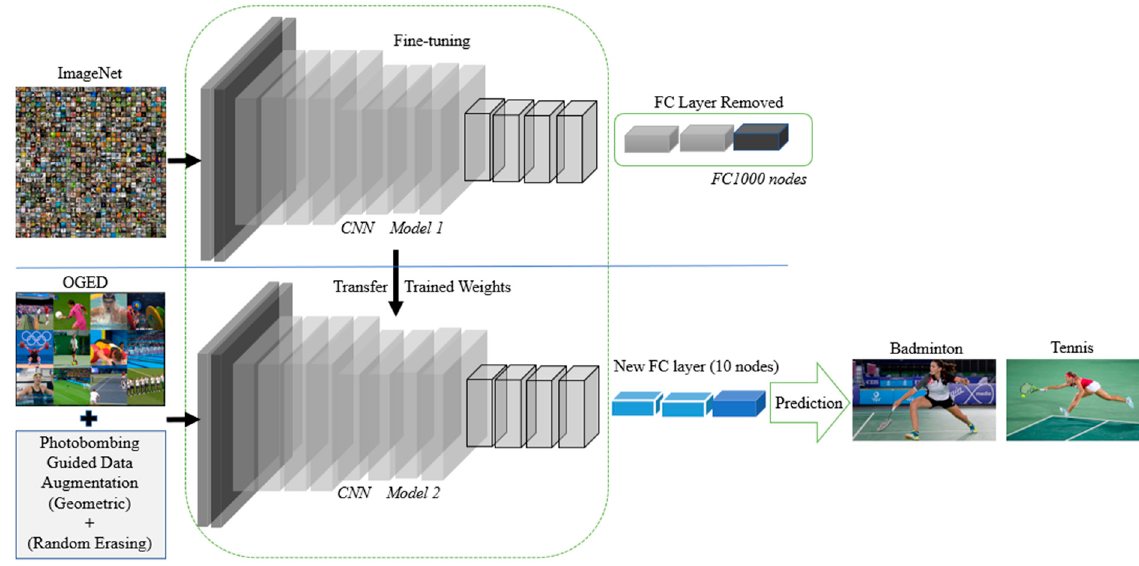
Figure 4. The pipeline of our proposed framework for event recognition via transfer learning and photobombing guided data augmentation.